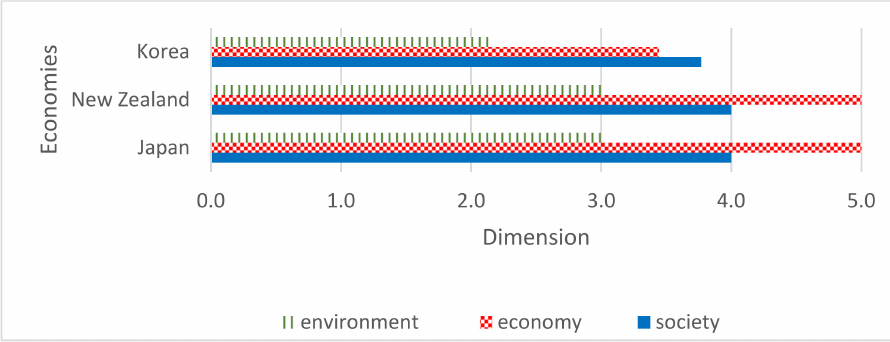
Figure 4. Sub-dimensional energy resilience of the Asia-Pacific